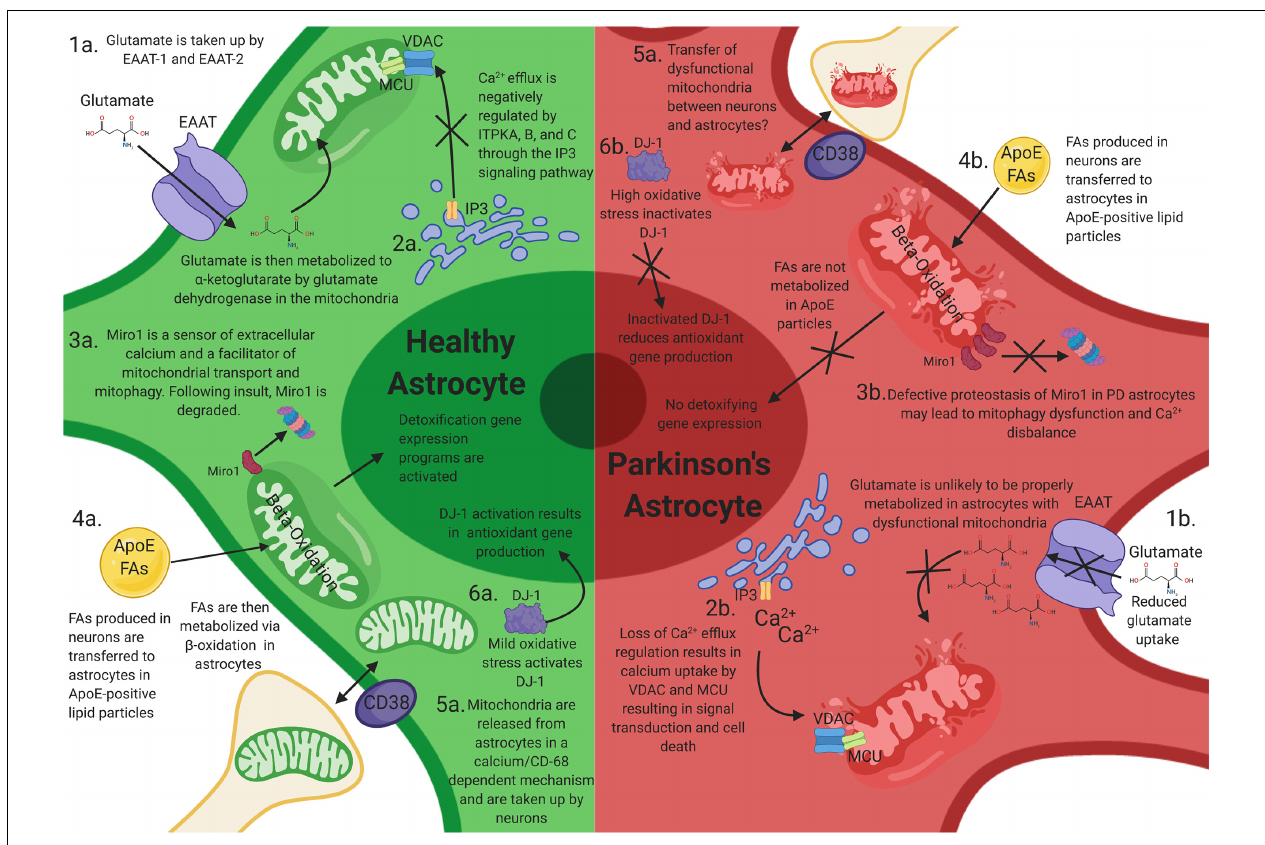
FIGURE 1 | How mitochondrial dysfunction in astrocytes can contribute to Parkinson’s disease (PD) progression. Mitochondrial dysfunction in astrocytes may elicit neuronal toxicity through multiple mechanisms. (1a) Functional astrocyte mitochondria are needed for glutamate regulation and metabolism. (1b) Dysfunctional astrocyte mitochondria likely have reduced glutamate uptake and metabolism, resulting in excitatory neurotoxicity in neurons. (2a) Astrocytes house large stores of intracellular calcium and other ions, which is negatively regulated by ITPKA, B, and C. (2b) Perturbations of these calcium reservoirs results in an increase in mitochondrial intracellular calcium through VDAC1 and MCU, resulting in signal transduction and astrocytic cell death. (3a) Miro1 is a sensor of extracellular calcium and a facilitator of mitochondrial transport and mitophagy. Following mitochondrial stress, Miro1 is degraded, which facilitates the clearance of damaged mitochondria. (3b) Defective proteostasis of Miro1 in PD astrocytes may lead to mitophagy dysfunction and Ca 2 + disbalance. (4a) Toxic fatty acids (FAs) are produced in neurons and are transferred to astrocytic lipid droplets by ApoE-positive lipid particles. Astrocytes then consume the FAs stored in lipid droplets via mitochondrial β -oxidation in response to neuronal activity and turn on a detoxification gene expression program. (4b) Loss of mitochondrial function in astrocytes prevents proper metabolism of these FAs and results in FA induced toxicity (4b) . (5a,b) Astrocytes serve as the primary cell type responsible for the clearance and transfer of damaged and healthy mitochondria to and from neurons. The transfer is completed in a calcium-dependent manner, regulated by CD38. During transmitophagy, mitophagy is thought to begin in neurons and be completed in astrocytes. (6a) Mild mtROS induces DJ-1 activation, which results in antioxidant gene transcription. (6b) High levels of mtROS inactives DJ-1 and prevents antioxidant gene